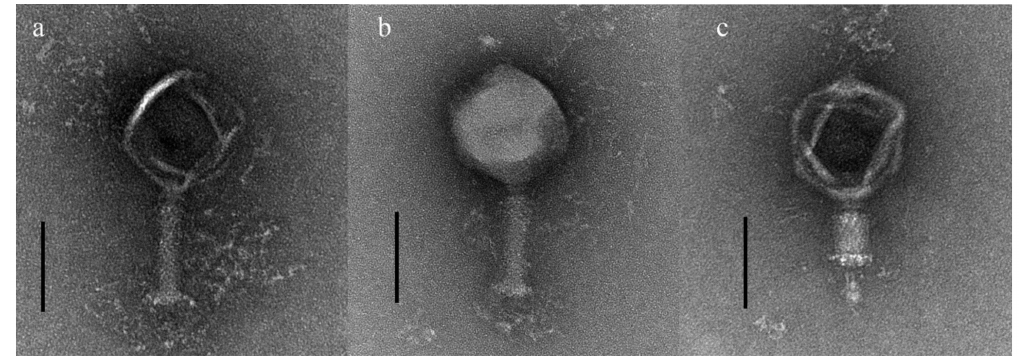
Figure 1. Transmission electron micrographs of Erwinia phages pEa_SNUABM_12 ( a ), pEa_SNUABM_47 ( b ), pEa_SNUABM_50 ( c ); the microscope was operated at 120kV. Scale bar: